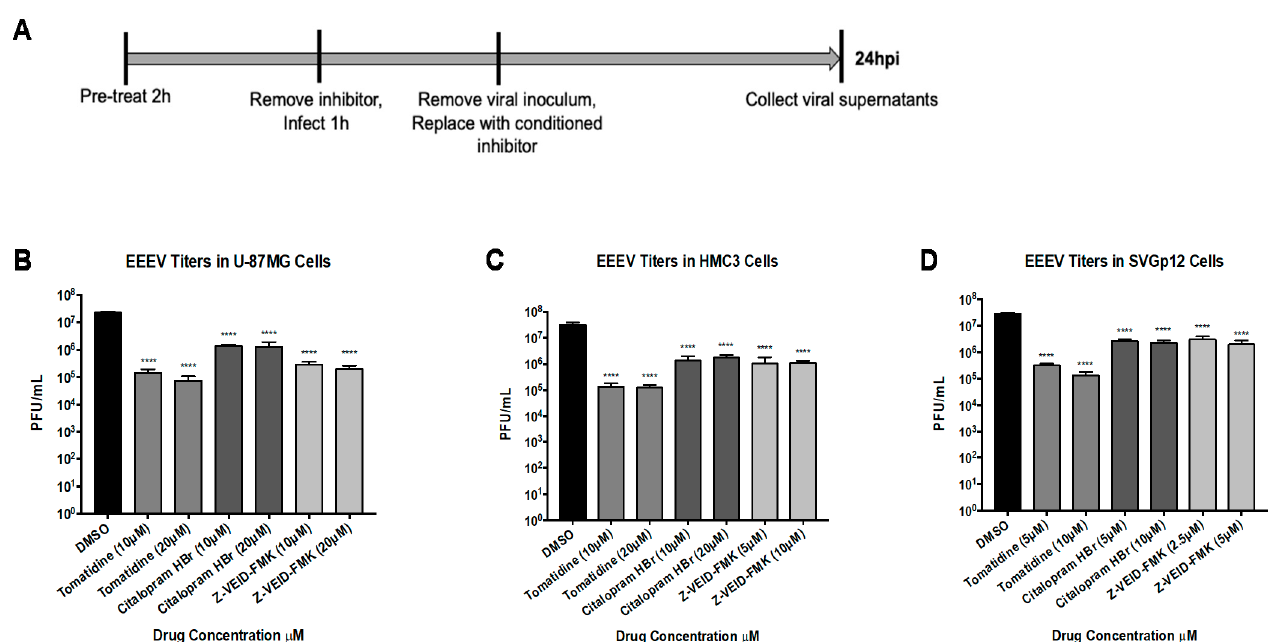
Figure 7. Tomatidine, citalopram HBr, and Z-VEID-FMK display efficacy against EEEV in a cell-type independent manner. ( A ) Schematic of infection scheme. Cells were pretreated with two nontoxic concentrations of tomatidine, citalopram HBr, or Z-VEID-FMK for 2 h, subsequently infected with EEEV at MOI 0.1 for 1 h, and conditioned media were replaced after the removal of viral inoculum. Viral supernatants were evaluated by plaque assay, as described in Materials and Methods. ( B ) Efficacy in U-87MG cells. ( C ) Efficacy in HMC3 cells. ( D ) Efficacy in SVGp12 cells. Graphs are representative of two independent experiments performed in technical triplicates ( n = 6). **** p < 0.0001.